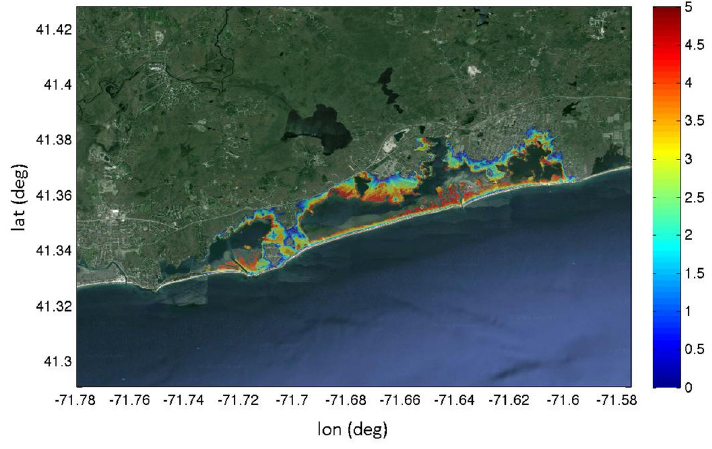
Figure 6. Controlling wave height (m) for Charlestown, RI, 100 year event, dune intact.